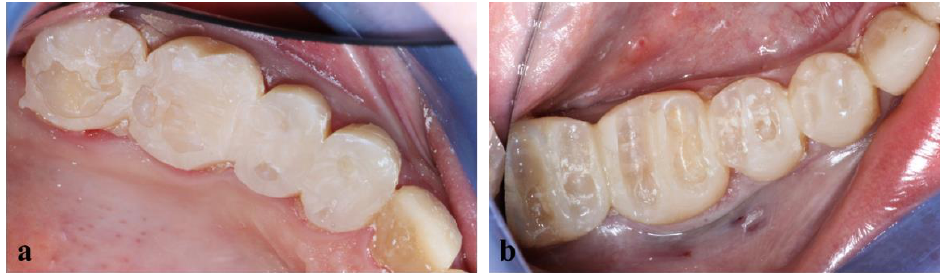
Figure 7. Virtual image of the recorded mock-up resulting from the optical impression. Teeth of the upper (a) and lower (b) right pre-molar and molar sectors were prepared through the mock-up as shown in Figure 8.